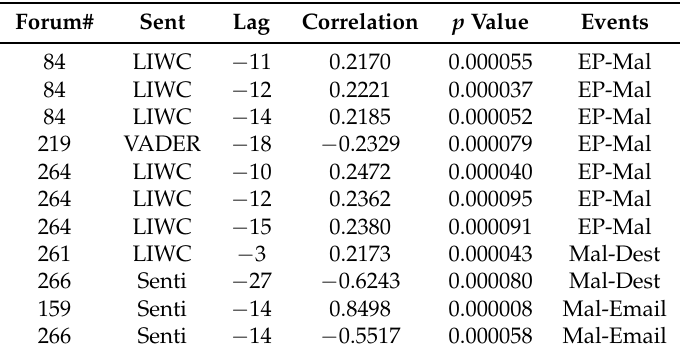
Table 2. Best Signals for Organization B’s